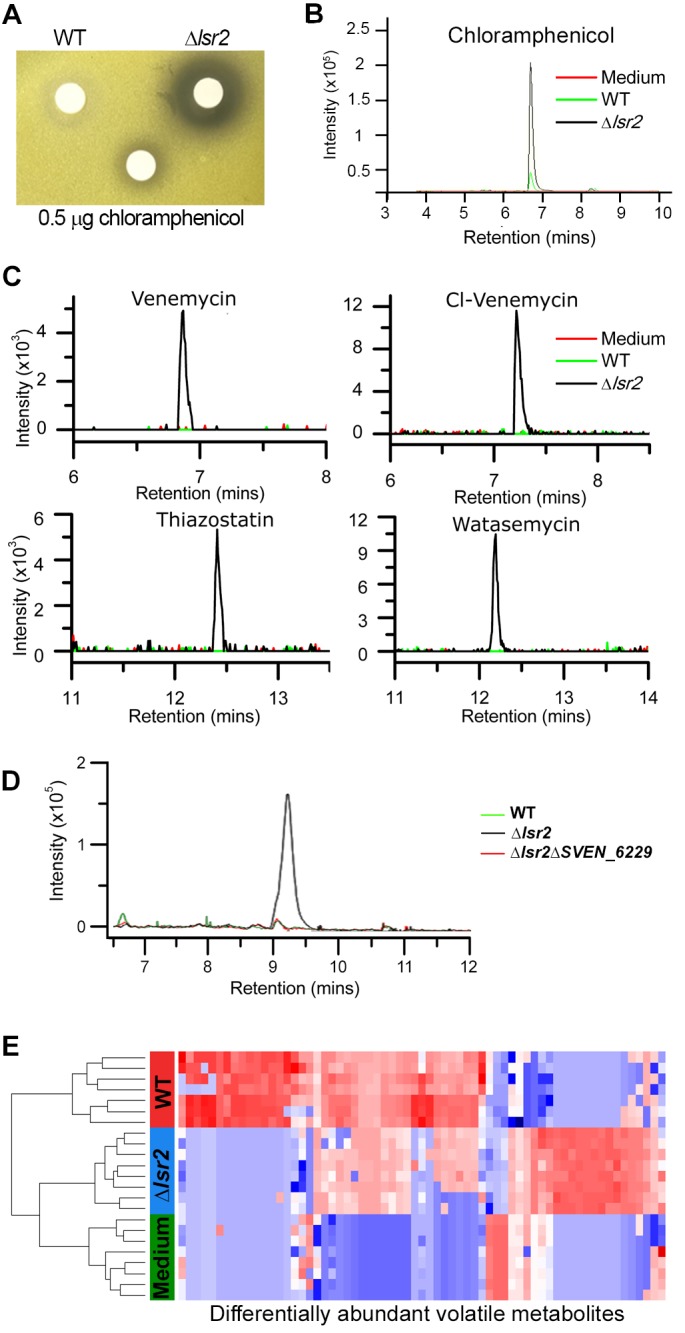
Specialized and volatile metabolite comparisons between wild type and lsr2 mutant strains.(A) Bioactivity of S. venezuelae extracts against Micrococcus luteus. Wild type and lsr2 mutant strains were cultured for 18 hr prior to extraction in methanol and reconstitution in DMSO. Extracts were applied to Whatman filter discs, alongside a chloramphenicol positive control. (B) Extracted ion chromatogram for chloramphenicol (m/z 321.005), from LC/MS analysis of methanol extracts from wild type and lsr2 mutant cultures grown in MYM liquid medium for 3 d, alongside a medium (MYM) control. (C) Extracted ion chromatograms of [M-H]−=219.040 (venemycin); [M-H]−=252.992 (chlorinated venemycin); [M + H]+ = 353.099 (watasemycin); and [M + H]+ = 339.083 (thiazostatin), from LC/MS analyses of methanol extracts of wild type and lsr2 mutant strains grown for 3 d in MYM liquid medium. (D) Extracted ion chromatogram of m/z 281.068, from LC/MS analysis of methanol extracts of wild type, lsr2 mutant and double lsr2 sven_6229 mutant strains, grown in MYM liquid medium for 3 d. (E) Heat map depicting the 65 volatile compounds (columns) that were significantly different in relative abundance (p<0.05 after BH correction) between wild type (WT, red) and lsr2 mutant (Δlsr2, blue) strains. Sterile media (Media, green) is included for comparison. Cell color corresponds to relative compound abundance after log10-transformation, mean-centering, and unit-scaling, ranging from low abundance (blue) to high abundance (red). Dendrogram (left) was constructed using Euclidean distance as the distance metric.